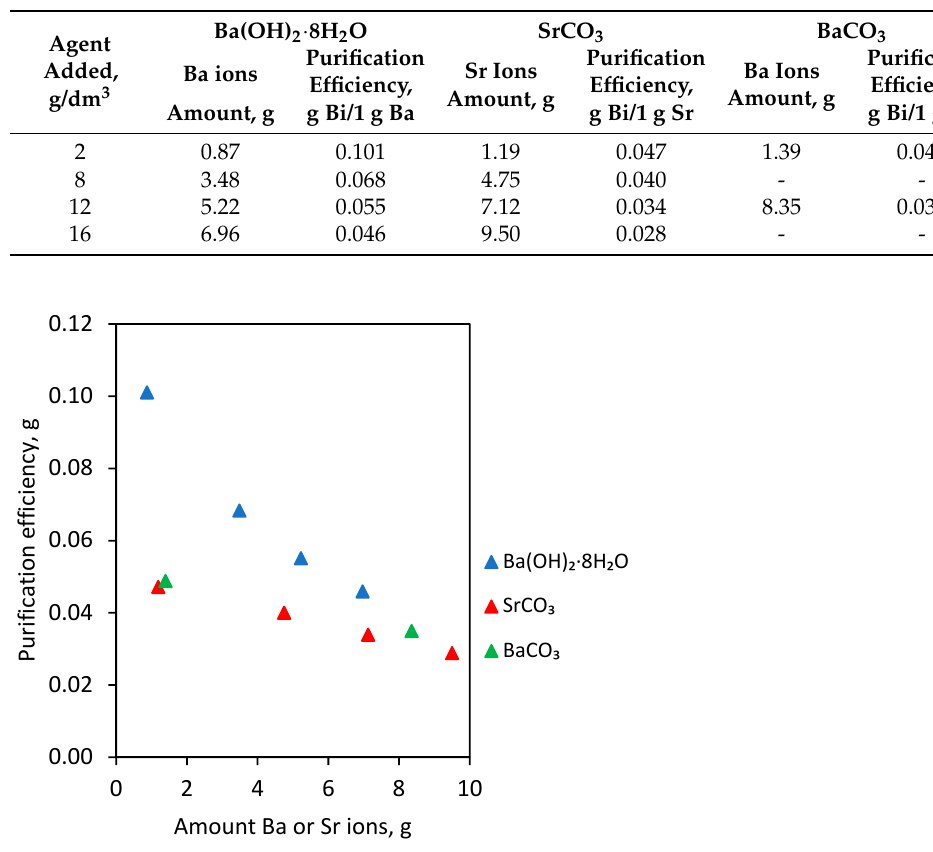
Figure 3. Bi amount removed in grams per 1 g Ba or Sr ions (purification efficiency) depending on the type and amount of agent added into S4 electrolyte.